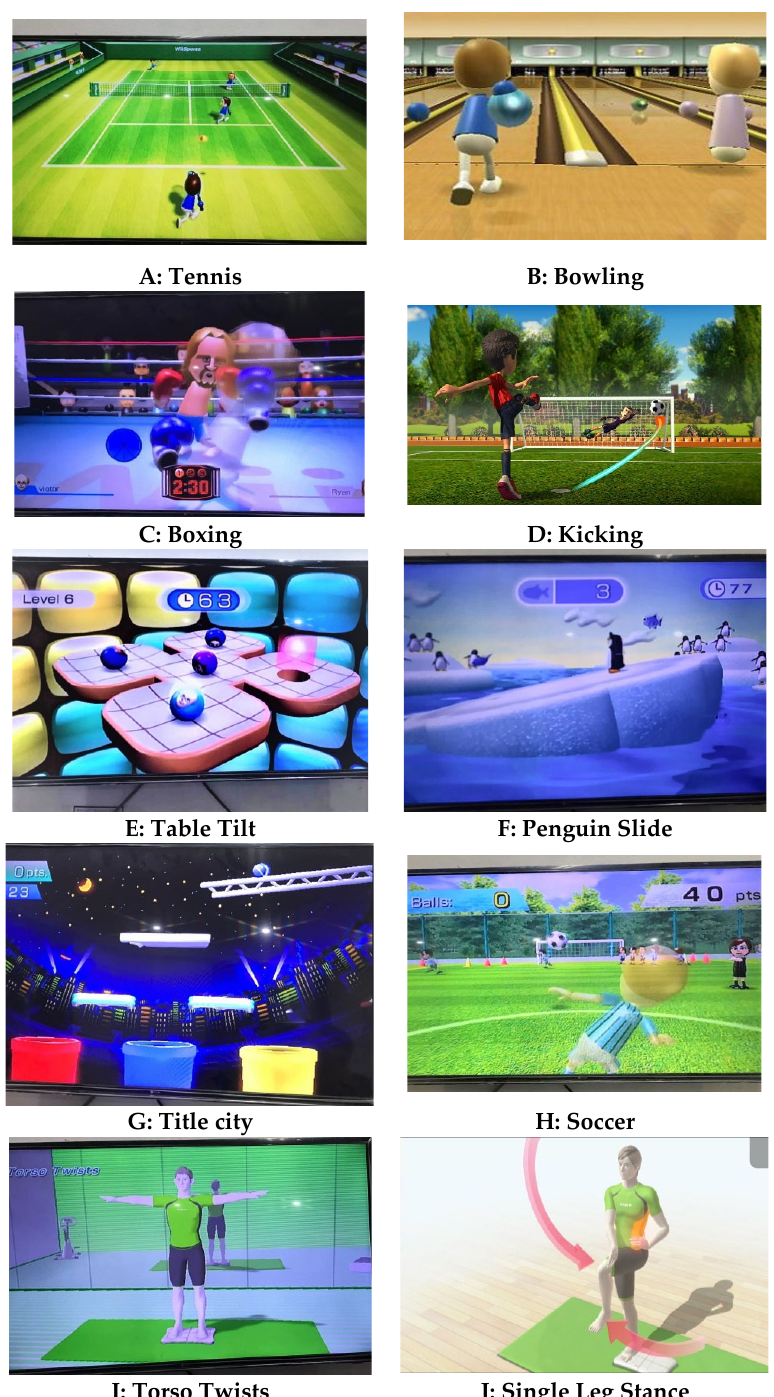
Figure 2. Games used in VR